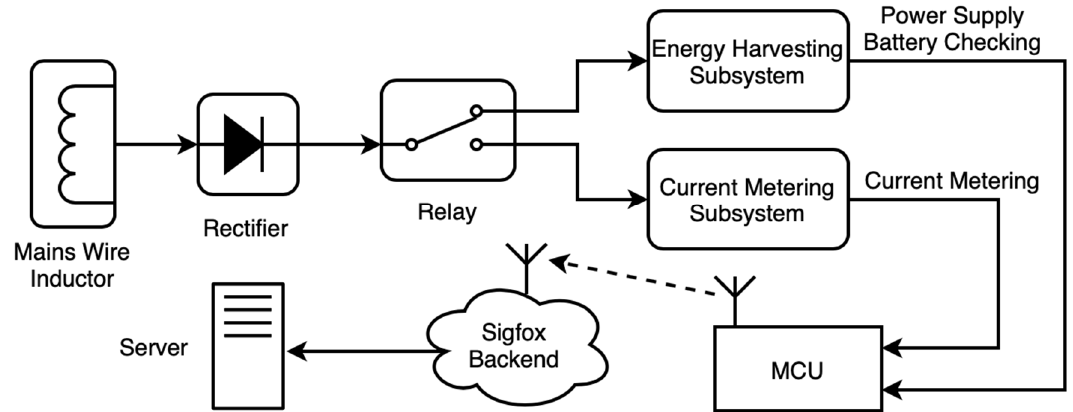
Figure 1. General block-diagram for the complete system, including the metering device itself and the communication to the server.